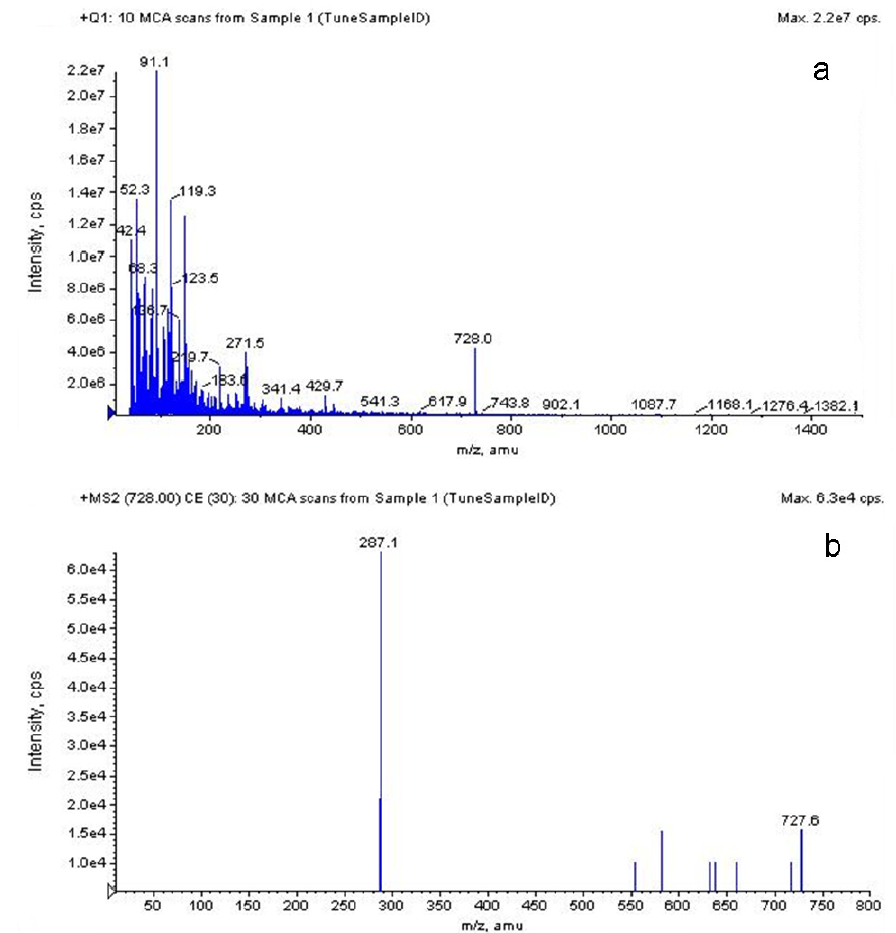
Figure 5. HPLC-MS Chromatograms of Cyanidin-3- O -xylosylrutinoside. ( a ) MS1 chromatograms of cyanidin-3- O -xylosylrutinoside under ESI-MS in positive mode; ( b ) MS2 chromatograms of cyanidin-3- O -xylosylrutinoside under ESI-MS in positive mode; ( c ) MS1 chromatograms of cyanidin-3- O -xylosylrutinoside under ESI-MS in negative mode; ( d ) MS2 chromatograms of cyanidin-3- O -xylosylrutinoside under ESI-MS in negative